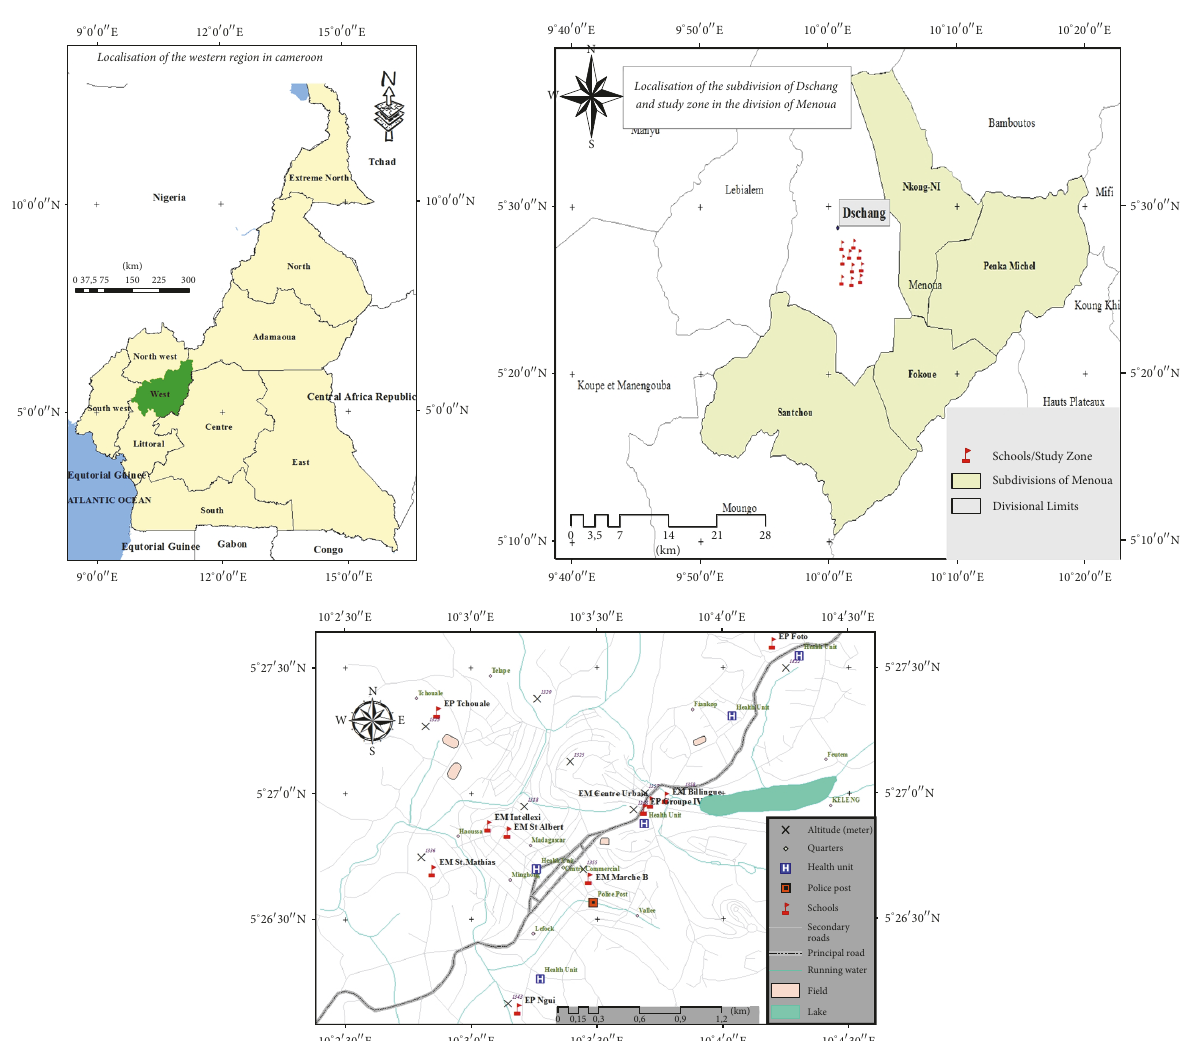
Figure 1: Study area and sampling points. Source : GPS Garmin; image satellite: QuickBird 2014, Dschang,